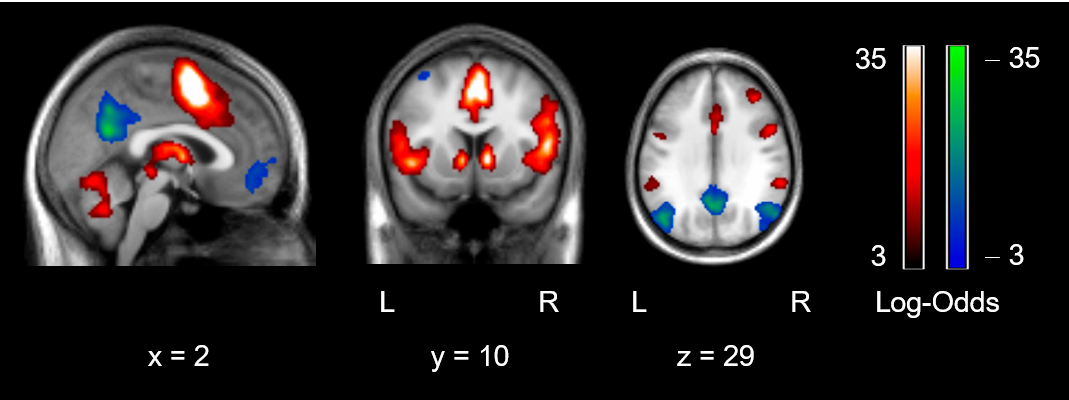
Figure 4. Statistical parametric maps of reward anticipation across participants and beta distributions per group. Neural correlates of a contrast representing CS+(monetary) > CS − (hot colors) and its reverse contrast (cold colors) across participants, using a threshold with an effect size of 1.0 and logBF = 7. x, y, z in Montreal Neurological Institute (MNI) space. L, left; R, right.